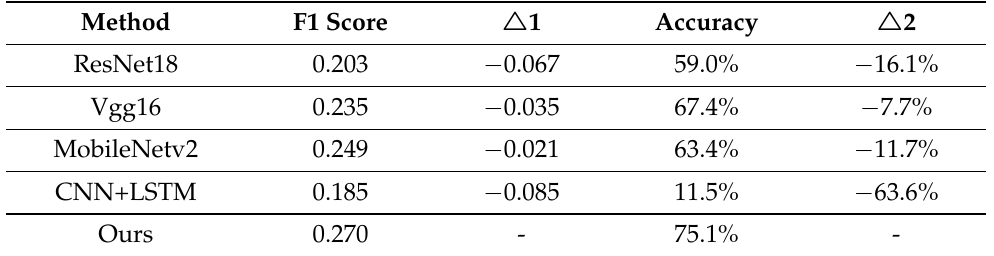
Table 3. Comparison of the geoeffectiveness prediction of CME events with other